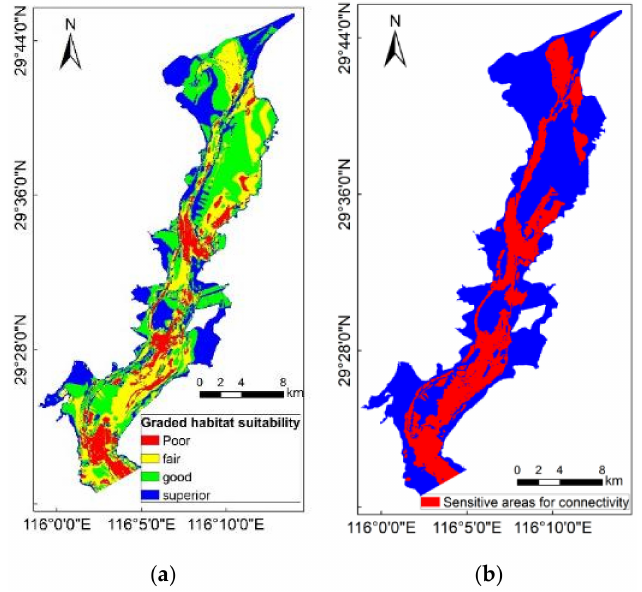
Figure 10. ( a ) Graded habitat suitability and ( b ) sensitive areas for